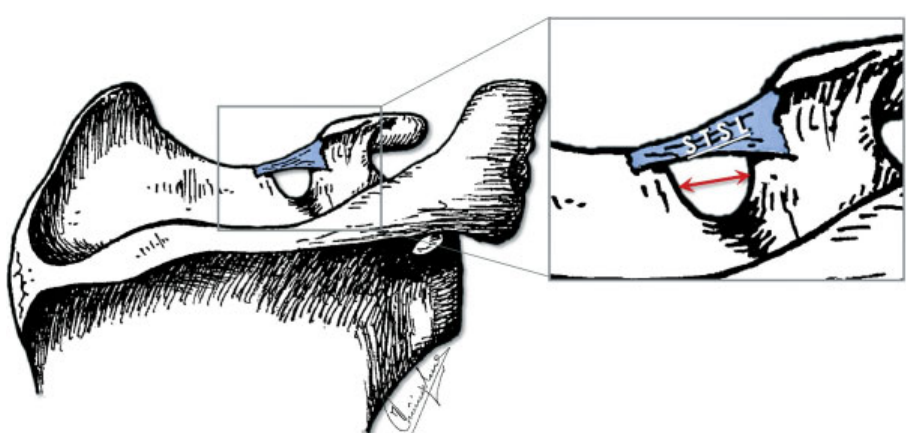
Fig. 1 Illustration of the scapula ’ s upper part, showing the distance measured as the SN ’ s middle-transverse diameter (red double arrow). SN, suprascapular notch; STSL, superior transverse scapular ligament.